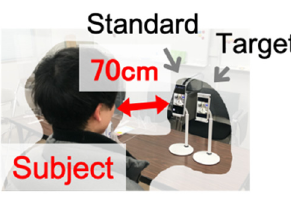
Figure 13. Experimental condition. Figure 12. Rating scales.